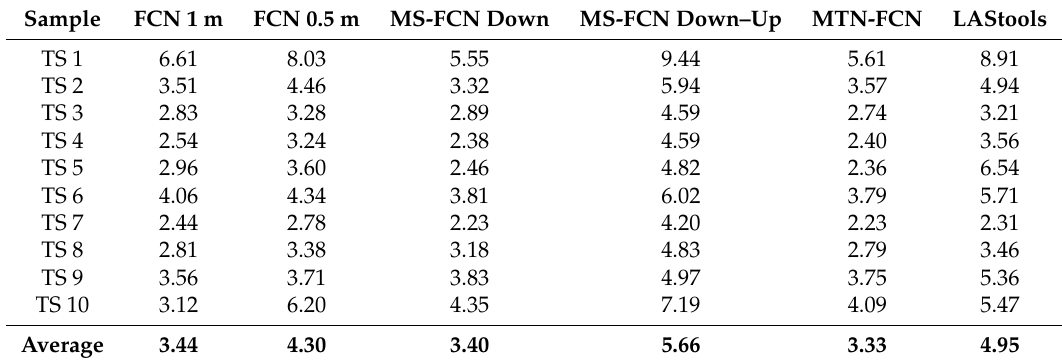
Table 7. Type-II errors of the AHN3